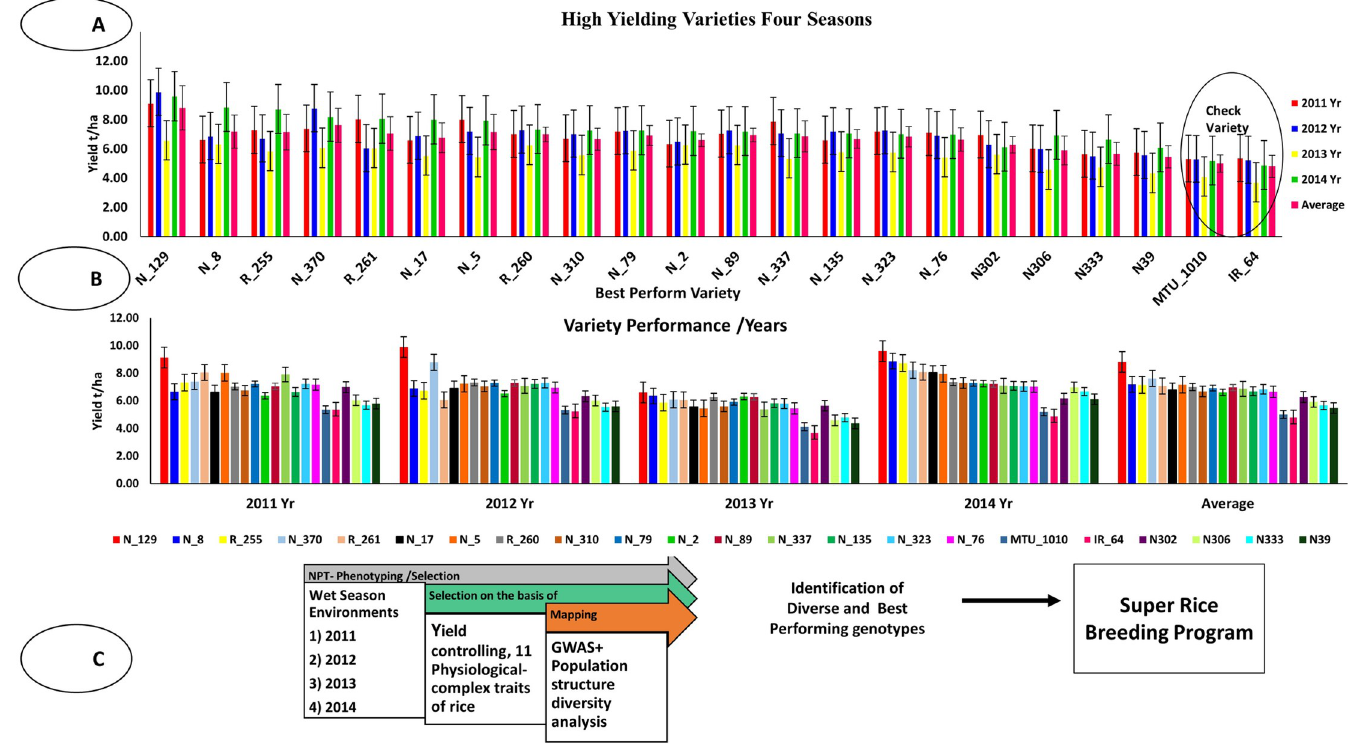
Fig 1. (A,B) Performance of New Plant Types (NPTs) with reference to check varieties based on high grain yield in different seasons. (C) The working hypothesis fulfil the objective of the study. The circle of (A) indicates the performance of standard check varieties i.e. IR-64 and